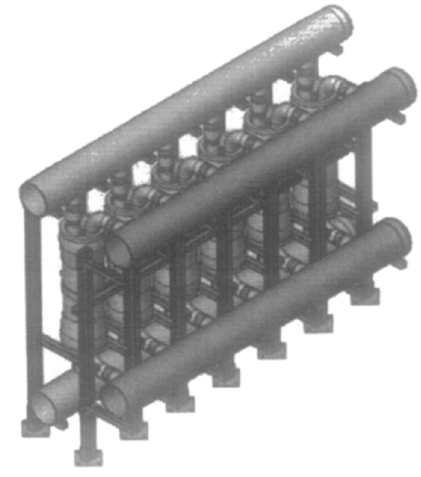
Figure 11. Twelve PX-120 arrays [45].